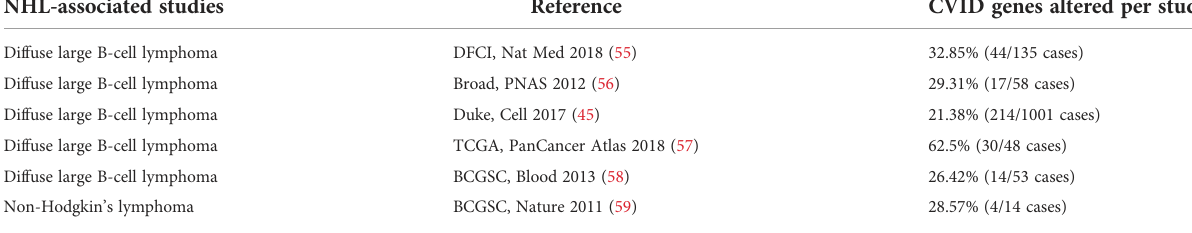
TABLE 1 NHL datasets available in cBioPortal (www.cbioportal.org; accessed in September 2021). NHL-associated